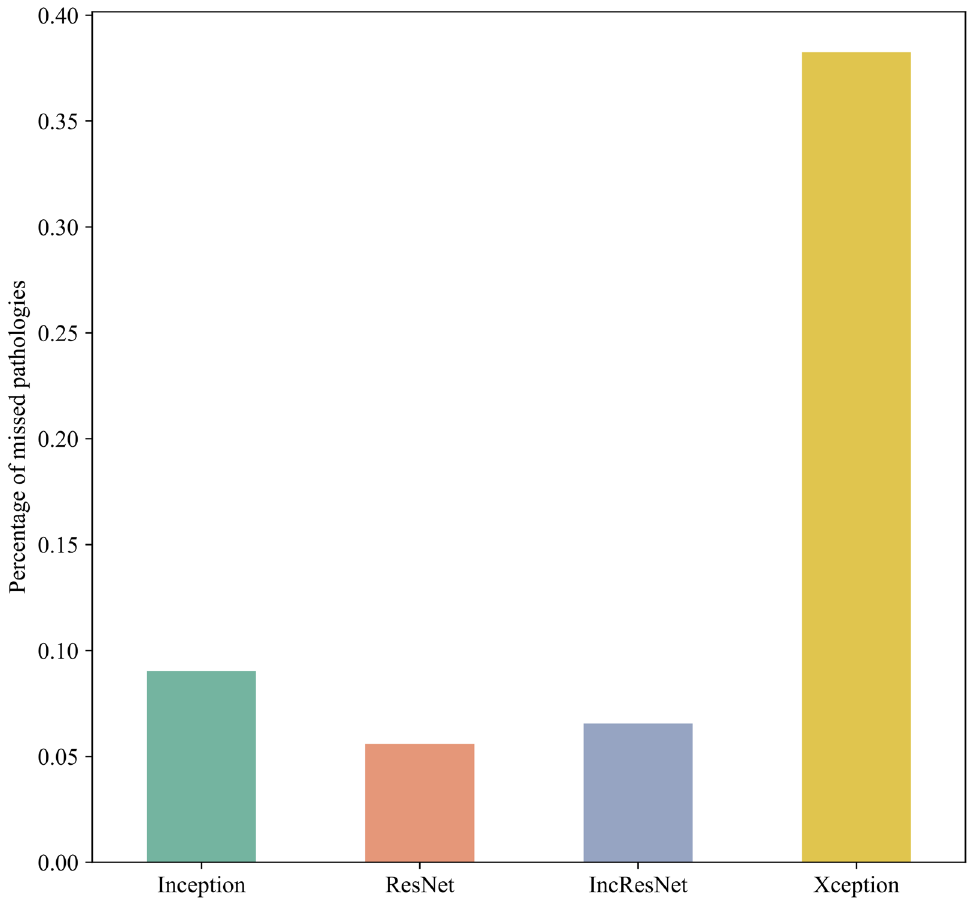
Figure 6. Overall DR pathology missed by different